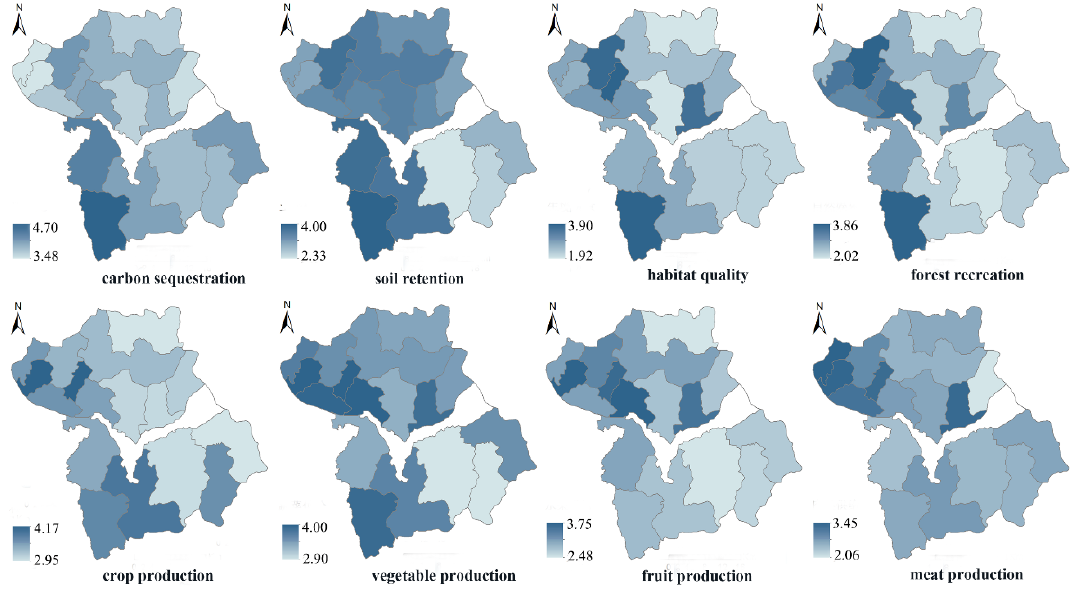
Figure 5. Spatial distribution of subjective preference based on the survey questionnaire.